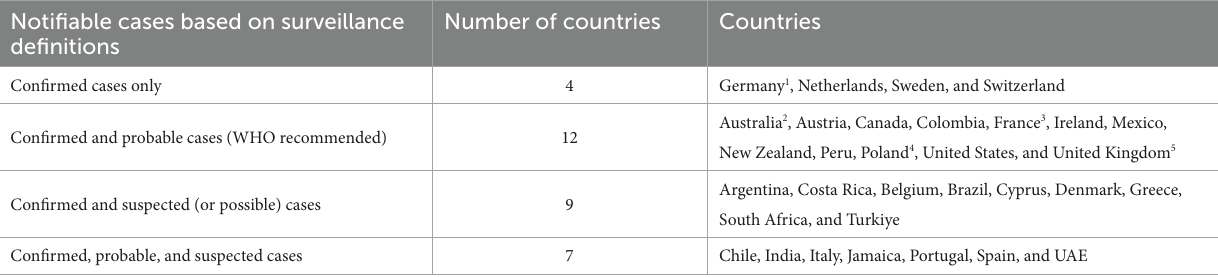
TABLE 4 Differences in notifiable cases based on surveillance